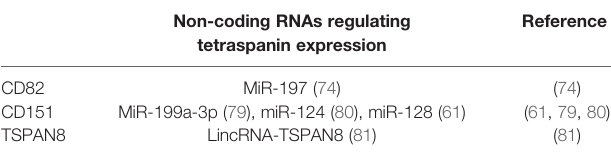
TABLE 1 | The non-coding RNAs that regulate the expression of tetraspanin. Non-coding RNAs regulating tetraspanin